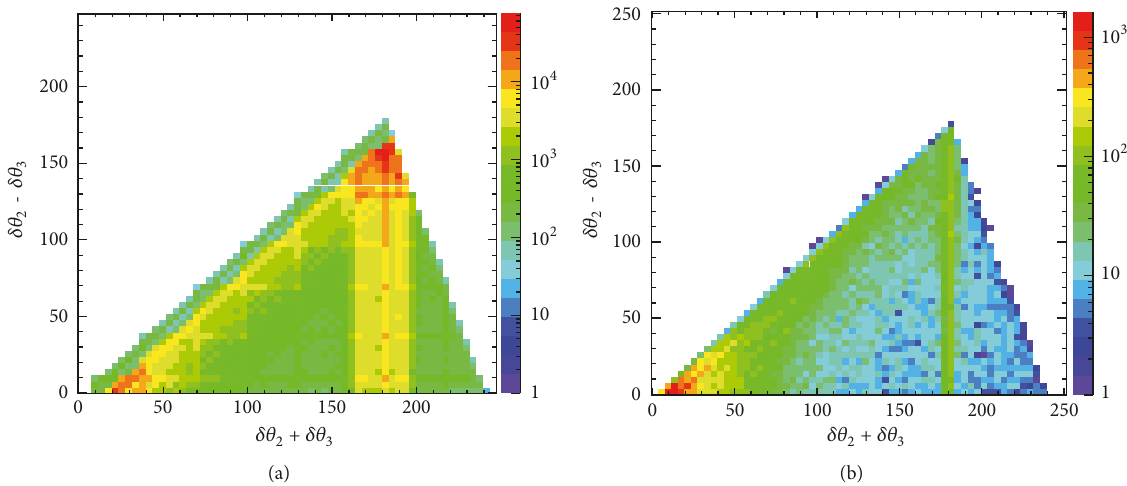
Figure 7:Relations between thesum and differenceof two smallest relativeazimuthal angles ( 𝛿𝜃 2 and 𝛿𝜃 3 , respectively)between 𝛾 interaction points in events with three recorded interactions. (a) Distribution obtained in the test measurement with the aluminium chamber presented in Figure 3. For reference, the same spectrum obtained with a point-like annihilation medium located in the detector center [59] is displayed in (b). The vertical band around 𝛿𝜃 2 + 𝛿𝜃 3 ≈ 180 ∘ arises from two-photon annihilations and is broadened in the first case due to extensive dimensions of the annihilation chamber used. 3𝛾 annihilation events are expected in the region located at the right side of the 2𝛾 band [60].